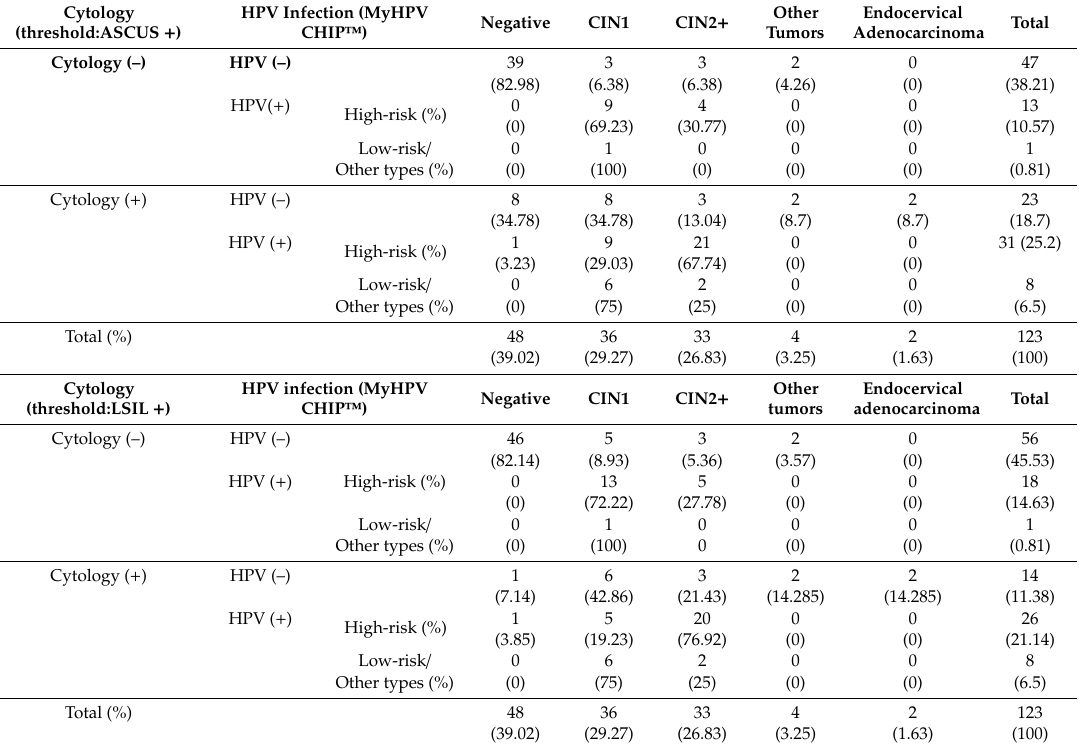
Table 10. Histological diagnosis in the MyHPV CHIP ™